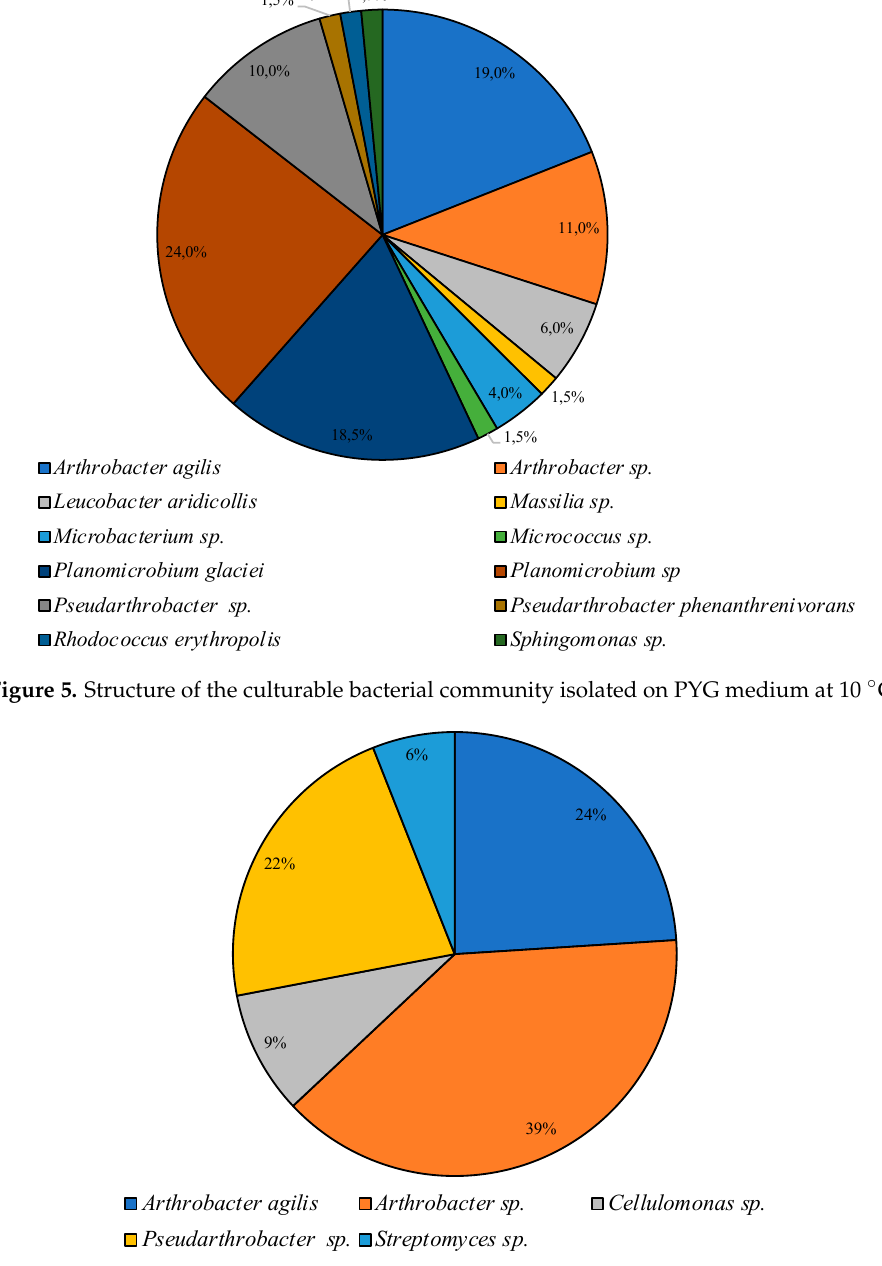
Figure 6. Structure of the culturable bacterial community isolated on CM medium at 10 °C.